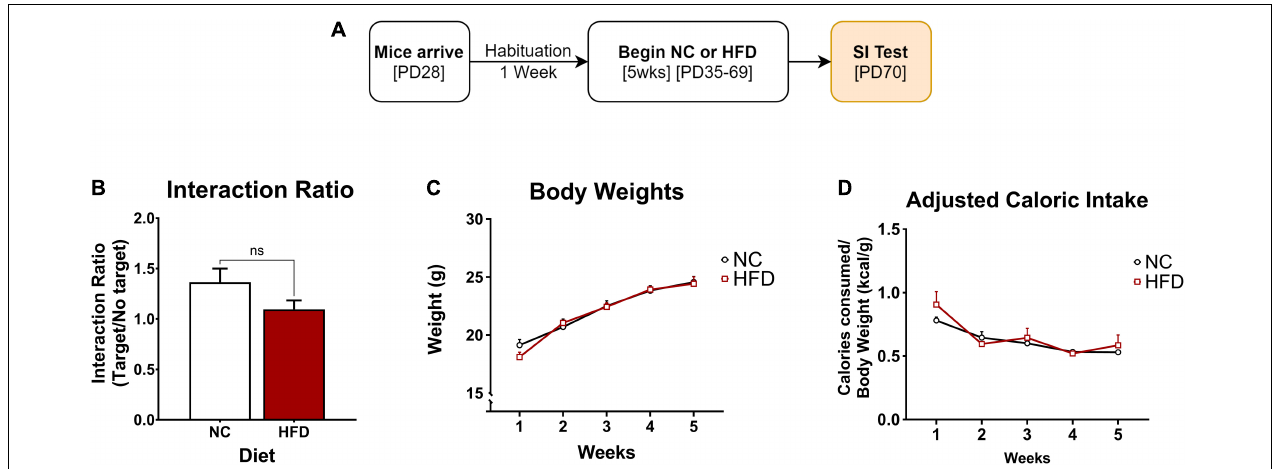
FIGURE 1 | Effects of 5 weeks of HFD on body weight, adjusted caloric intake, and social interaction. (A) Adolescent mice were habituated for one week, then exposed to 5 weeks of NC ( n = 8) or HFD ( n = 8) and tested for social interaction. (B) No difference in social interaction between the NC- and the HFD-exposed mice ( p > 0.05). (C) Mice in both NC and HFD conditions gained weight over time (main effect: p < 0.001) without an effect of diet (main effect: p > 0.05). (D) Each group showed a significant increase in the adjusted caloric consumption in week 1 compared to the rest of the weeks ( post hoc : ∗ p < 0.05: week 1 vs week 2), without significant differences between the two groups ( p > 0.05). ∗ p < 0.05: significantly different from NC. All data are expressed as the mean ±